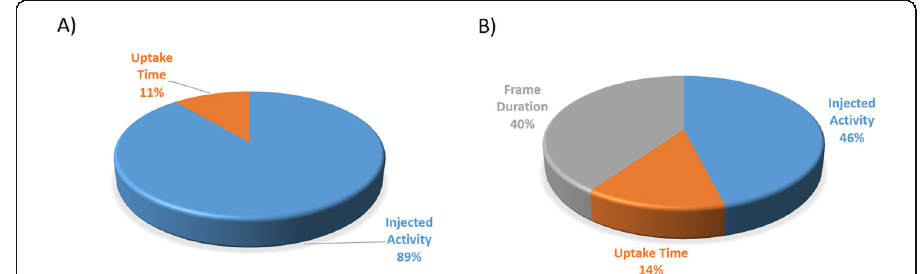
Fig. 4 Summary relative frequencies of non-correctable errors in bone scans ( a ) — 313 cases — and in 18 F- FDG whole-body PET-CT ( b ) — 154